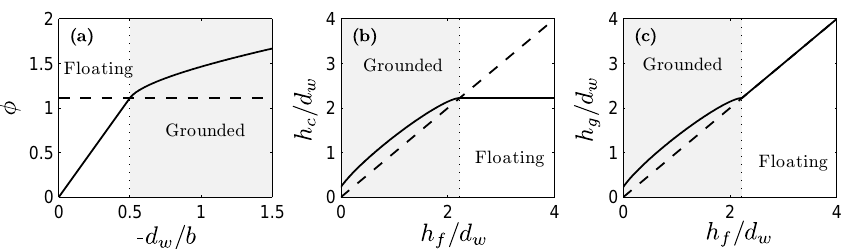
Figure 2. Calving laws. In all three panels, a solid line refers to the CD calving law, and a dashed line to the FL law. The grey shaded region refers to parts of parameter space where the calving front is grounded for the CD law, and white background to a floating calving front. r = 0 . 9 throughout. (a) The calving-front-thickness-to-bedrock-depth ratio φ as a function of normalized water depth − d w /b . For the FL law, the ratio is simply r − 1 . (b) Normalized calving front thickness h c /d w as a function of normalized flotation thickness h f /d w = − b/(rd w ) at the grounding line. (c) Normalized grounding line thickness h g /d w as a function of normalized flotation thickness h f /d w